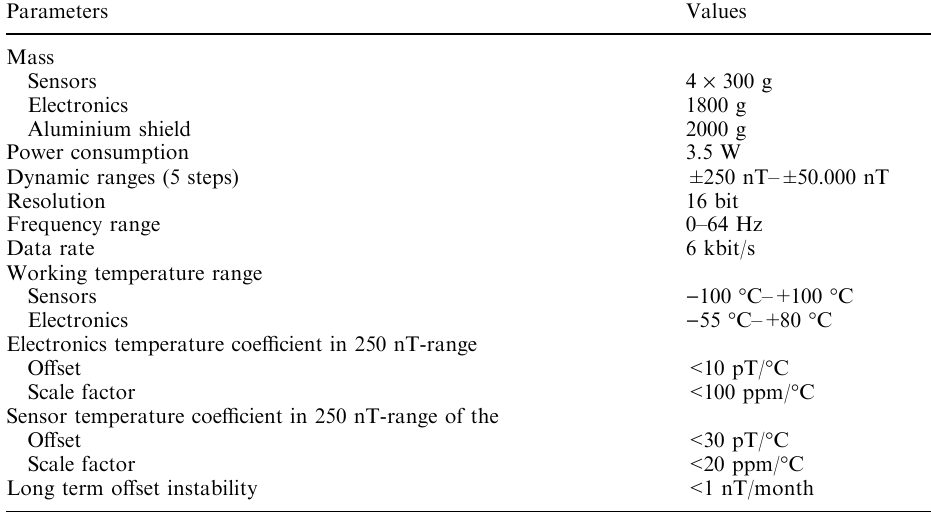
Table 1. Main technical para- meters of